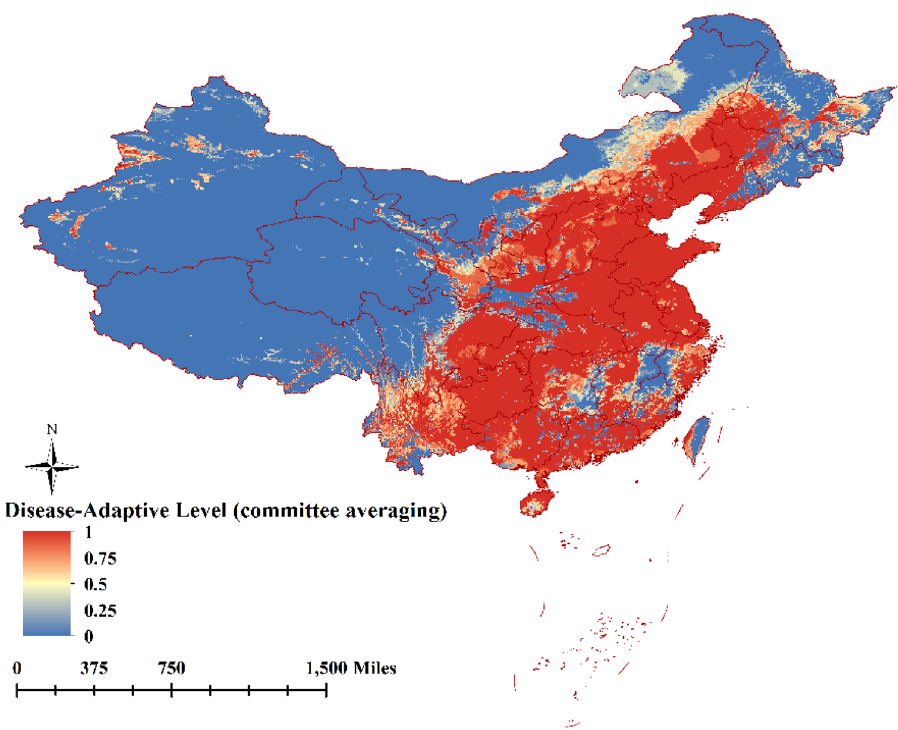
Figure 3. The disease-adaptive level of the ensemble model was expressed as the committee averaging (The map is made by ArcGIS10.2 https:// www. esri. com/ and R 4.1.3 software https:// mirro rs. bfsu. edu. cn/